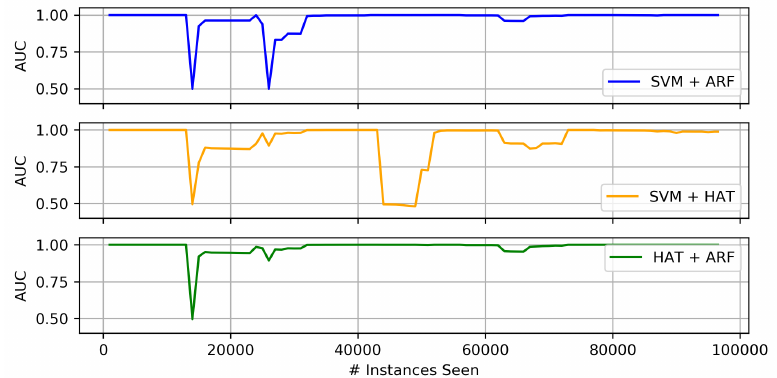
Figure 3. Comparison of heterogeneous ensemble performances on the SMTP data